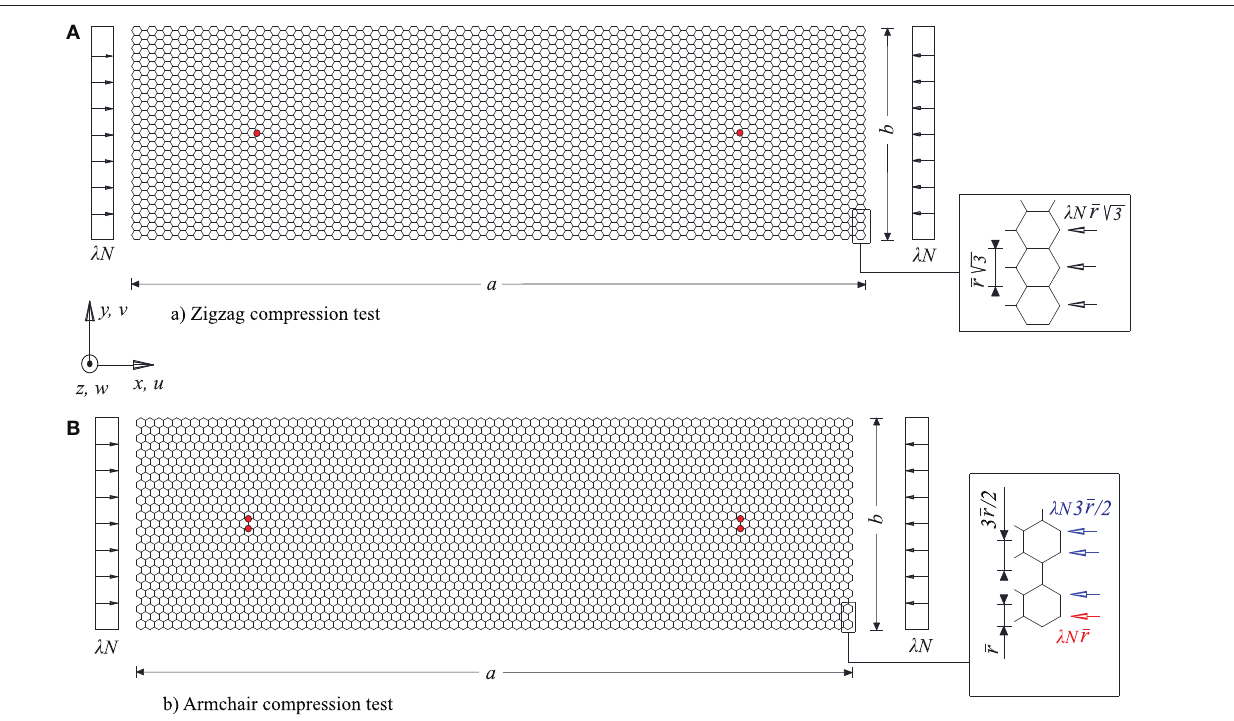
FIGURE 8 | Schemes of the compression tests of the graphene strips: (A) geometry and details of the applied loads for the compression test in the zigzag direction, (B) geometry, and details of the applied loads for the compression test in the armchair direction.